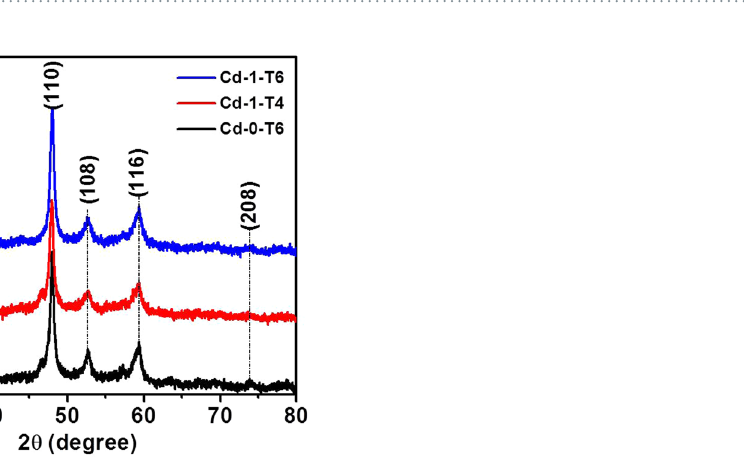
Figure 1. XRD patterns of as-prepared samples with various amounts of CdCl 2 ∙2.5H 2 O contents (Cd-0, Cd-0.5, Cd-1, Cd-2, and Cd-4) accompanying with the same other conditions.